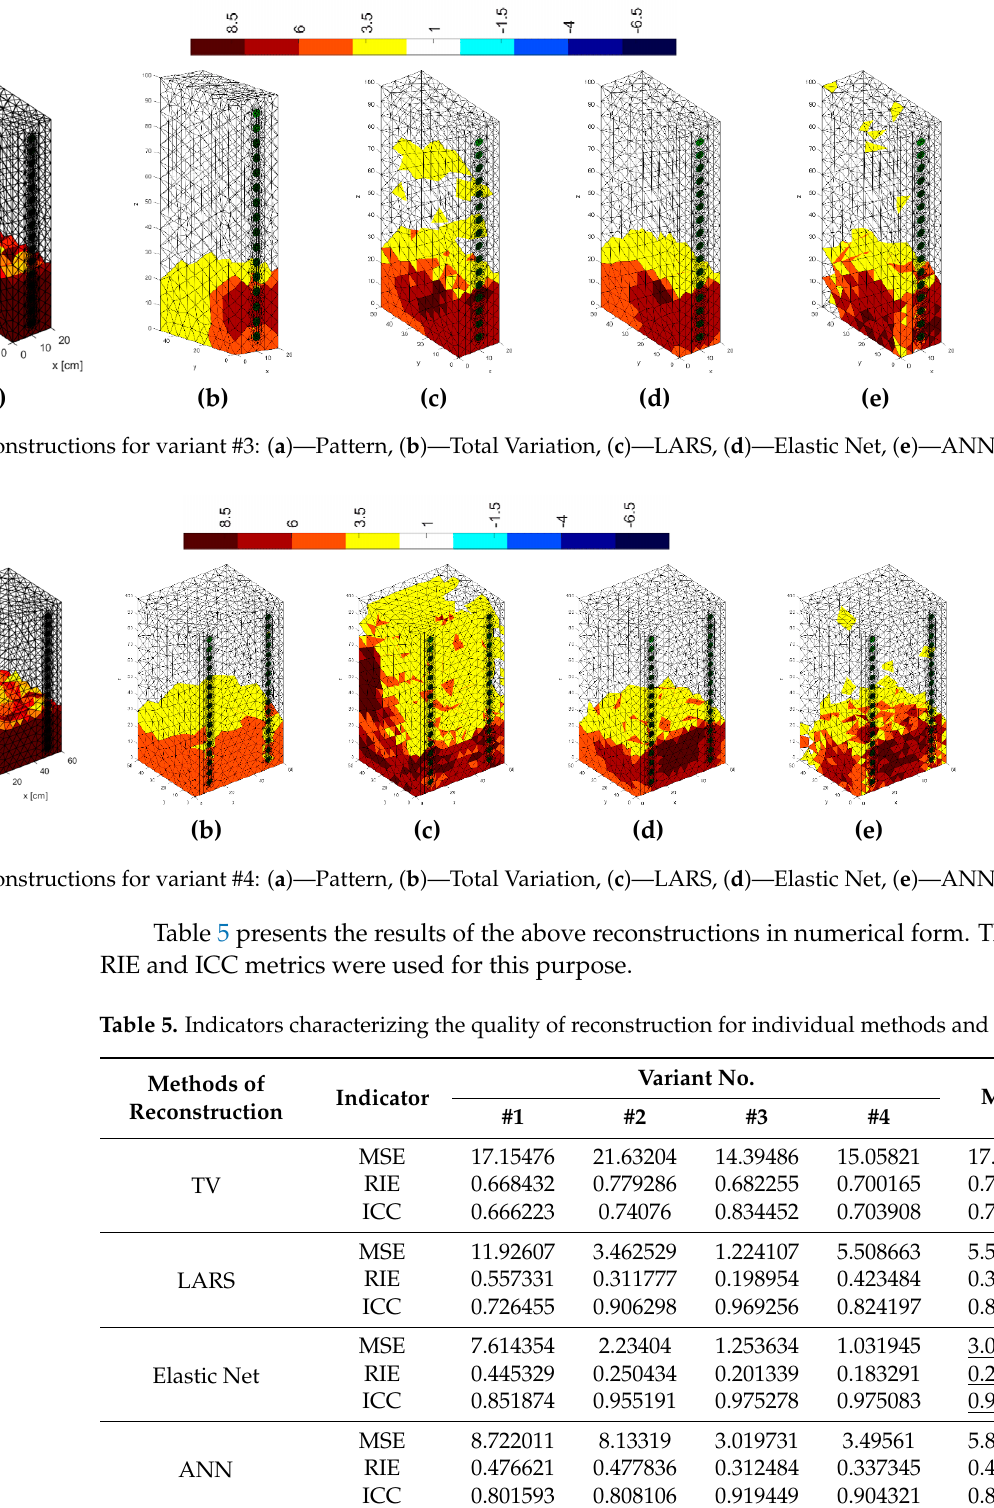
Figure 18. Reconstructions for variant #4: ( a )—Pattern, ( b )—Total Variation, ( c )—LARS, ( d )—Elastic Net, ( e )—ANN